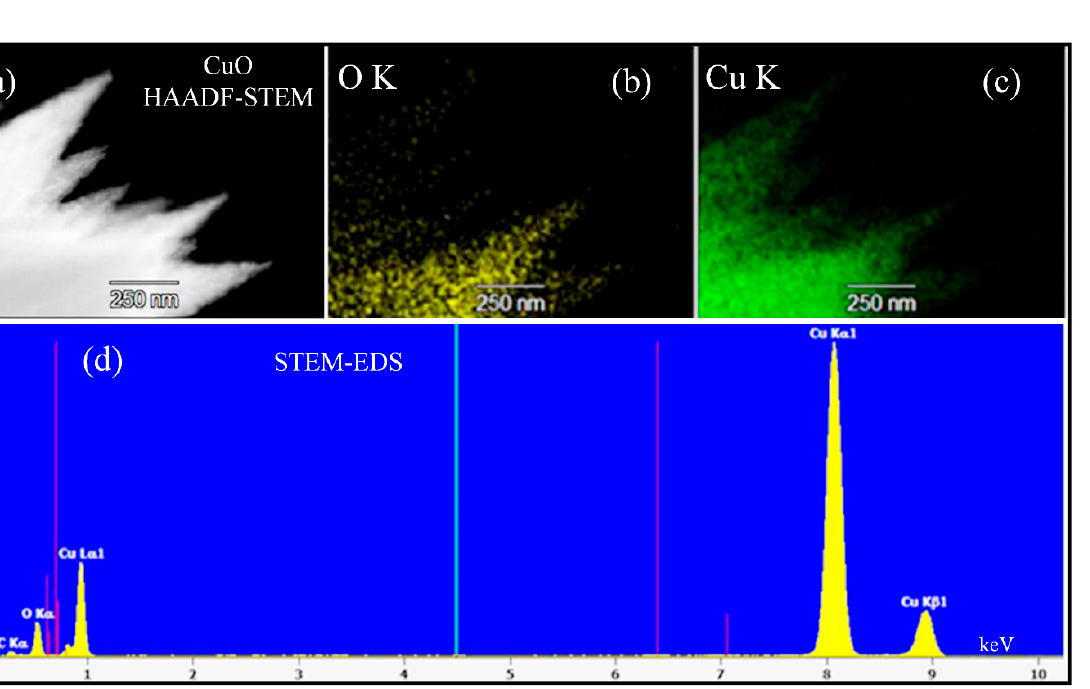
Figure 4. High-resolution TEM analysis of single copper oxide nanoflower. ( a – f ) TEM and HR- TEM images from low magnification to high magnification; ( g ) d-spacing; ( h ) SAED analysis; ( i ) HAADF-STEM.